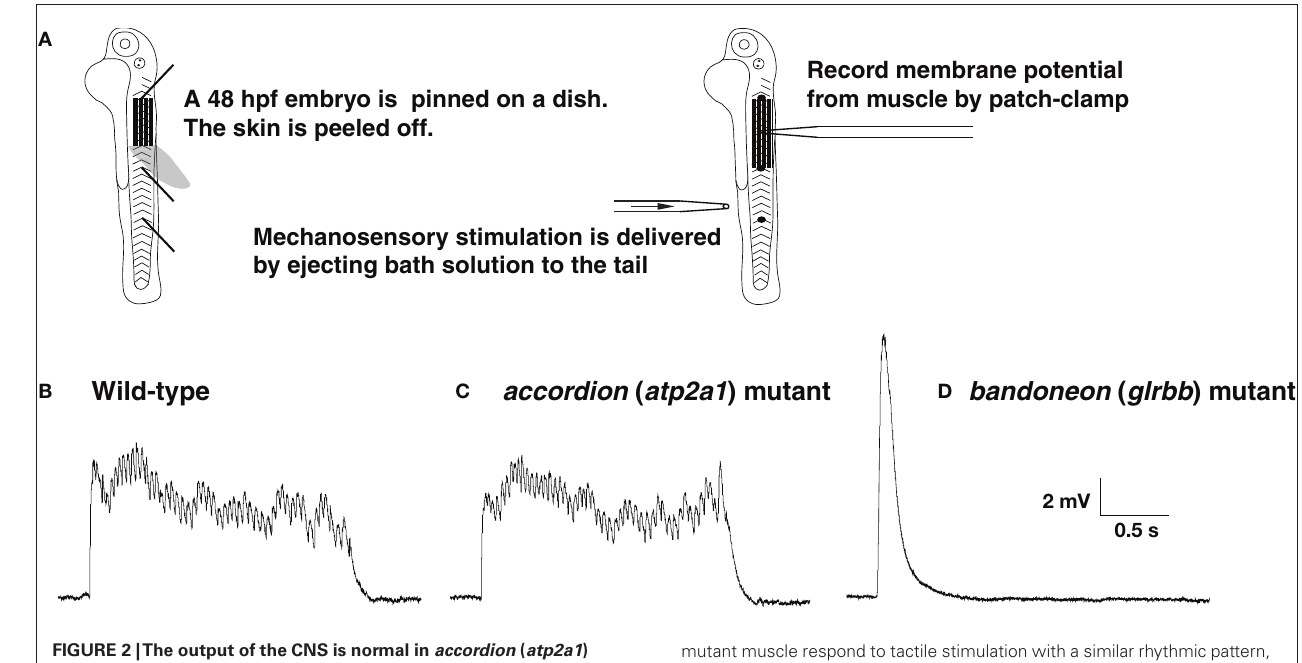
mutant muscle respond to tactile stimulation with a similar rhythmic pattern, indicating that the outputs from the CNS are normal. (D) bandoneon ( glrbb ) mutant muscle responds to tactile stimulation with a short and large voltage response devoid of rhythmicity, suggesting that the CNS outputs are